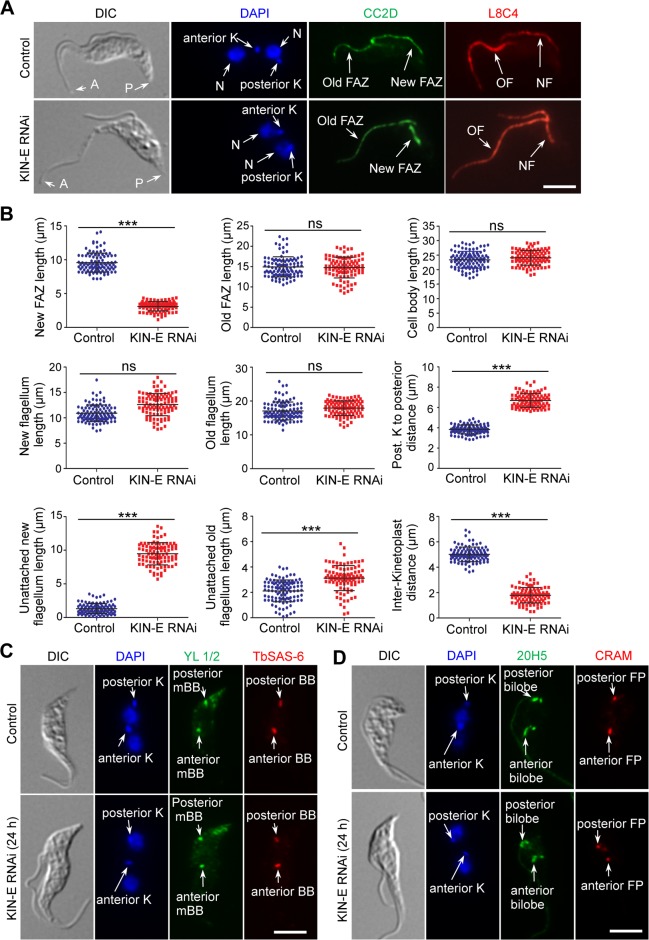
KIN-E RNAi disrupted the elongation of the new FAZ and the migration of the kinetoplast/basal body towards cell posterior.(A). Morphology of 2N2K cells from control and KIN-E RNAi cells. 2N2K cells from control and KIN-E RNAi-induced population were immunostained with anti-CC2D and anti-PFR2 (L8C4) antibodies to label the FAZ and the flagellum, respectively. Cells were counterstained with DAPI to stain nuclear (N) and kinetoplast (K) DNA. NF, new flagellum; OF, old flagellum. Scale bar: 5 μm. (B). Morphometric measurement of uninduced control cells and KIN-E RNAi-induced (24 h) cells. 2N2K cells from control and KIN-E RNAi cells (+Tet, 24 h) were immunostained with anti-CC2D and anti-PFR2 antibodies. The length of the cell body, the new FAZ, the old FAZ, the new and old flagella, the unattached new and old flagella, posterior kinetoplast to cell posterior distance, and inter-kinetoplast distance were measured and plotted (n = 103 for control cells and n = 97 for RNAi cells). ***, p<0.001; ns, no statistical significance. (C). Position of the flagellar basal body in control and KIN-E RNAi cells. Shown are 2N2K cells that were co-immunostained with YL 1/2 antibody to label the mature basal body (mBB) and with anti-TbSAS-6 antibody to lable the total basal body (BB) that is composed of mBB and pro-basal body (pBB). Cells were then counterstained with DAPI for nuclear and kinetoplast DNA. Scale bar: 5 μm. (D). Positions of the bilobe structure and the flagellar pocket in control and KIN-E RNAi cells. Shown are 2N2K cells that were co-immunostained with 20H5 antibody and anti-CRAM antibody to label the bilobe structure and the flagellar pocket (FP), respectively, and then counterstained with DAPI for nuclear and kinetoplast DNA. Scale bar: 5 μm.